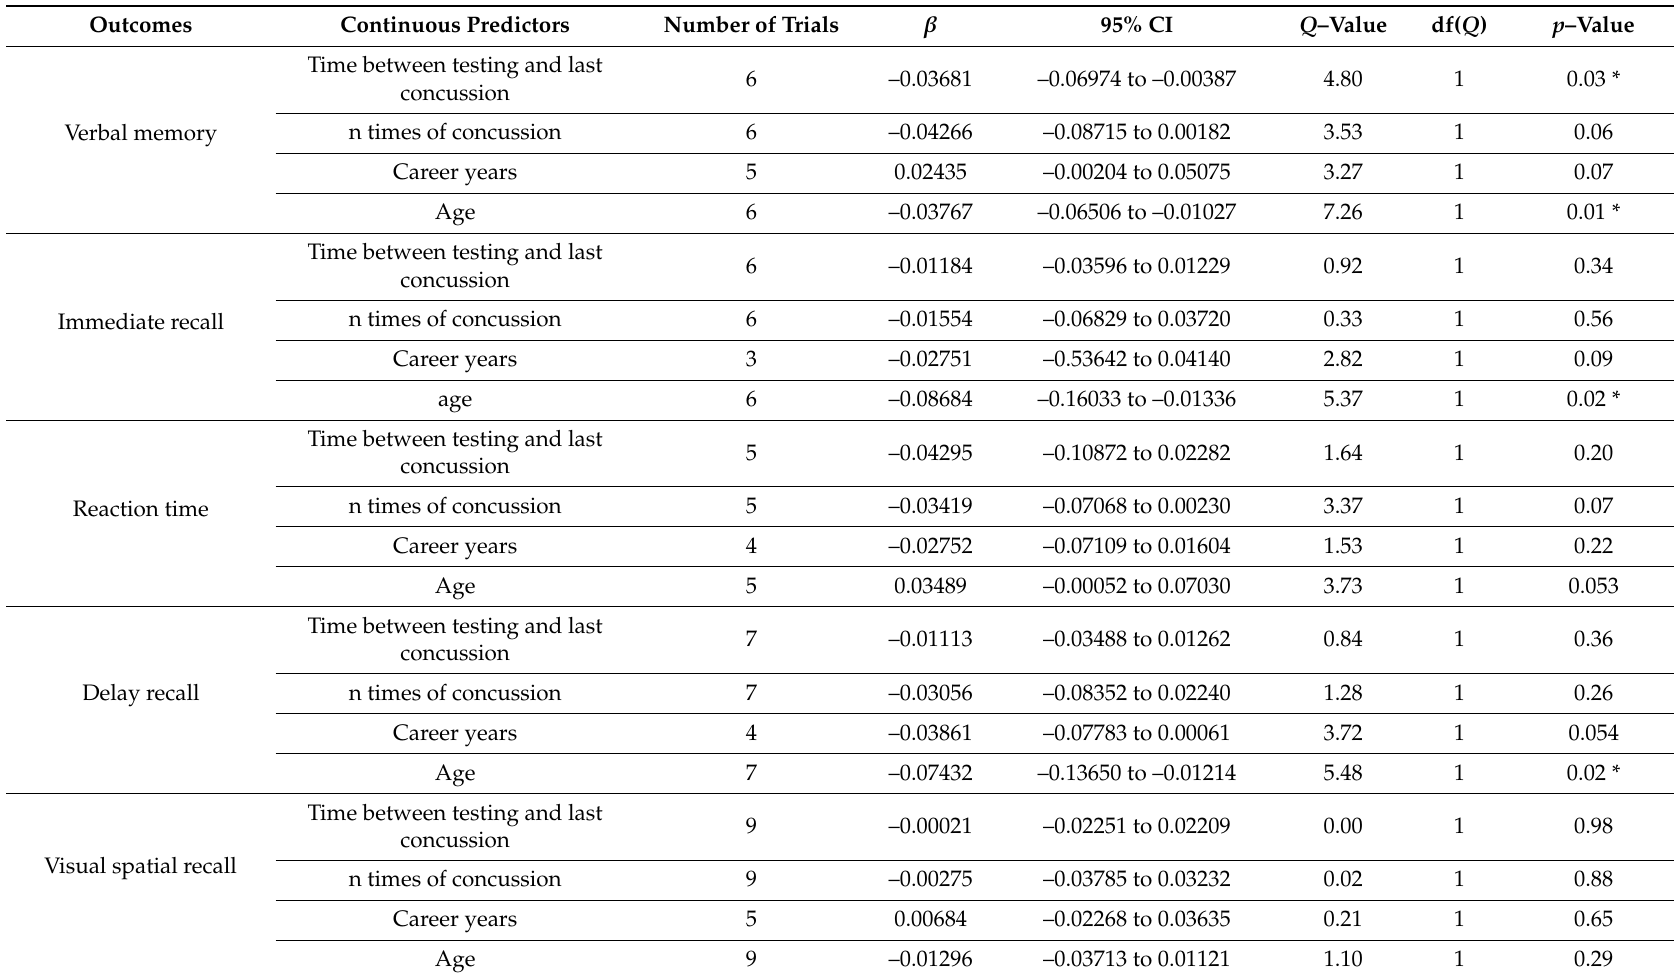
Table 3. Moderator analysis for the e ff ects of concussed group vs. control